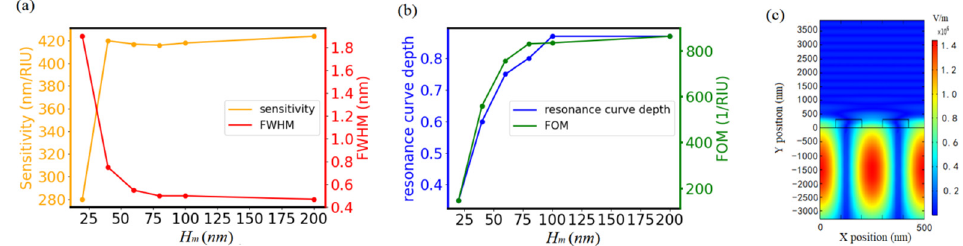
Figure 3. ( a ) Dependence of sensitivity and FWHM on H m . ( b ) Dependence of FOM and resonance curve depth on H m . ( c ) Electric field distribution of GMR with no metal reflector layer. For simulation, Λ was set at 500 nm, H g at 300 nm, fill factor f at 0.25, and f i at 0.2.